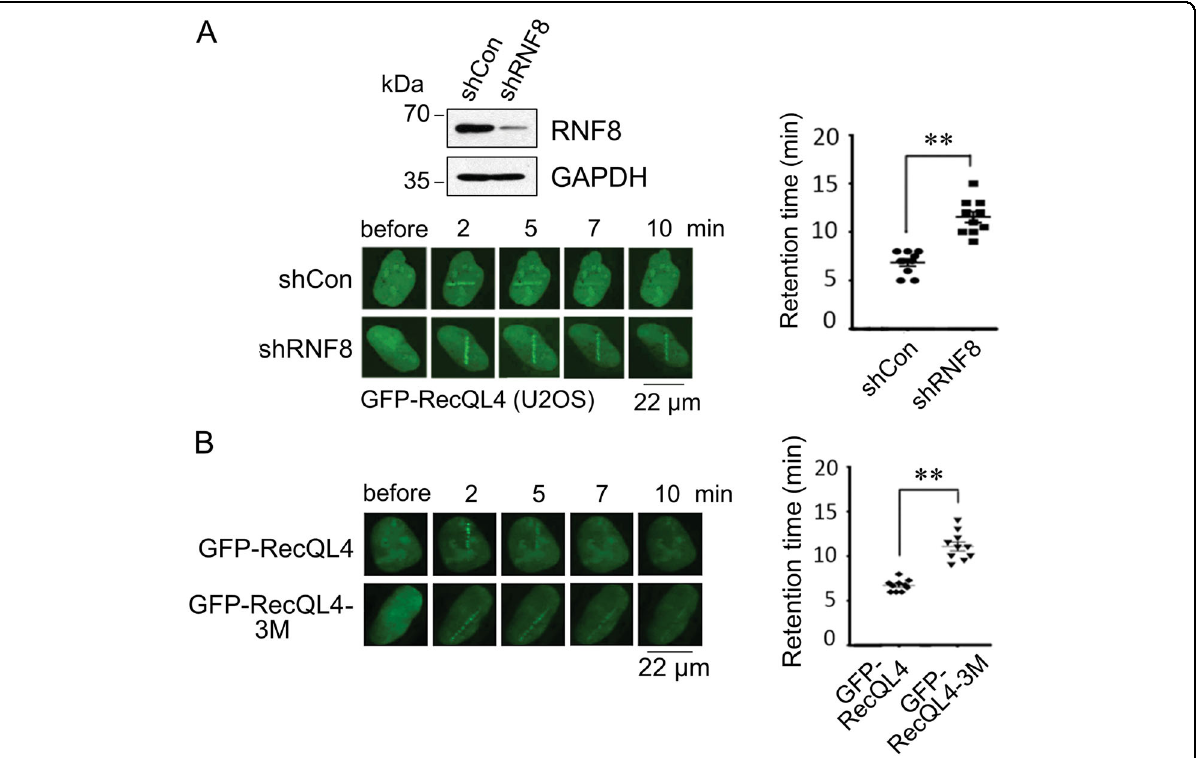
Fig. 3 RNF8 promotes RecQL4 dissociation from DSBs. A Knockdown of RNF8 signi fi cantly inhibits the dissociation of RecQL4 from DSBs. U2OS cells with or without RNF8 depletion were treated with 365-nm micro-point laser. The recruitment of GFP-RecQL4 at DSBs was recorded and the fl uorescence density was quanti fi ed. B The prolonged and enhanced recruitment of RecQL4-3M at DSBs induced by UV micro-point laser. U2OS cells were transfected with GFP-tagged WT RecQL4 or its 3M mutant, and subjected to UV micro-point laser treatment. The recruitment of GFP-RecQL4 or its mutant at DSBs were recorded and the fl uorescence density at DSBs was quanti fi ed. At least 15 cells were analyzed for each treatment. The data represent mean ± SEM from three independent experiments. ** p <